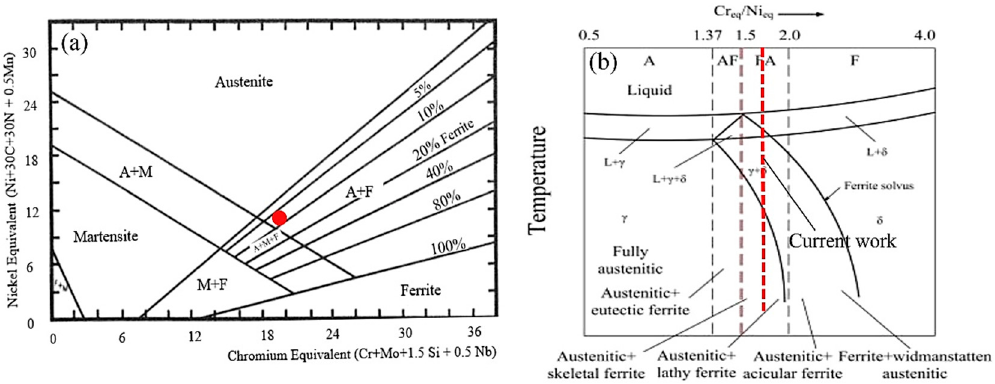
Figure 10. ( a ) Schaeffler constitution diagram showing the location of the composition of the AISI 316L stainless steel powders, ( b ) pseudo-binary phase diagram [37].